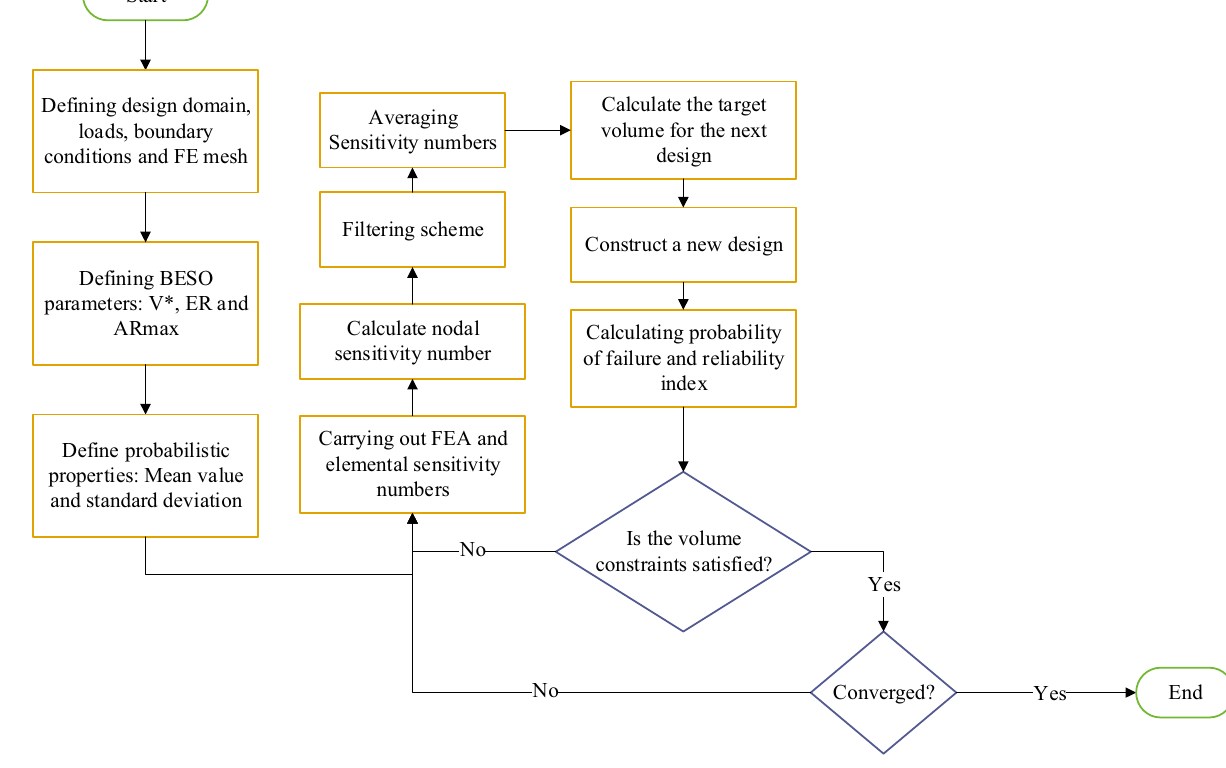
Figure 1. Flow chart of the elasto-plastic reliability-based BESO topology